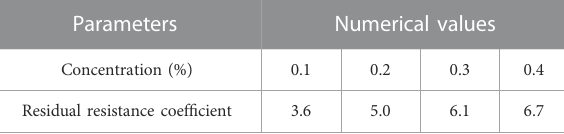
TABLE 6 Residual resistance coef fi cient corresponding to different concentrations of dispersion